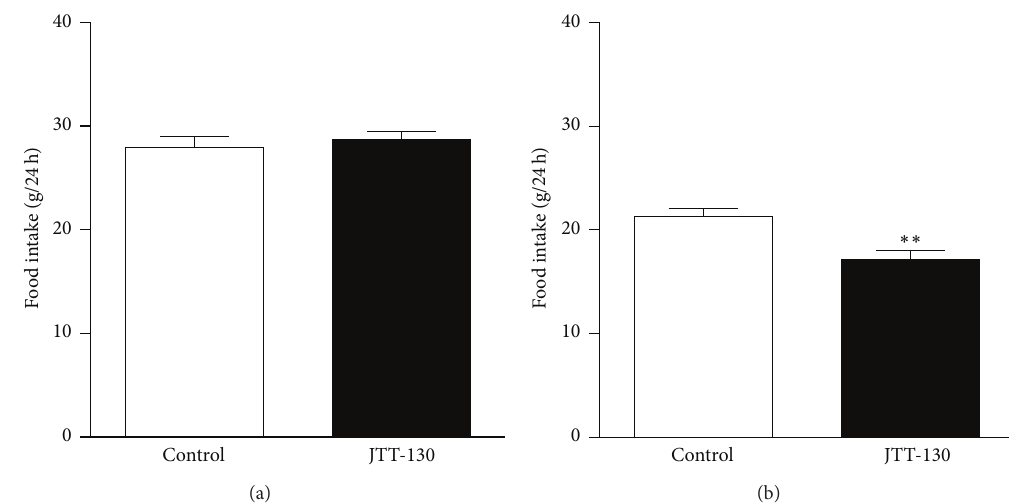
Figure 1: Effects of dietary fat on the suppression of food intake by JTT-130. Effect of JTT-130 on the suppression of food intake was assessed as described previously [15]. JTT-130 was administered orally to rats at a dosage of 10mg/kg after 24 h food deprivation. Rats were allowed to have free access to 3.1% fat (a) or 35% fat (b) diets immediately after JTT-130 dosing. Cumulative food intake was monitored for up to 24 h after dosing JTT-130. Data are presented as means ± S.E. from six animals. ∗∗ 𝑃 < 0.01 versus control group. Table 2: Effect of JTT-130 on food intake from LF and HF diets during the experiment. Study